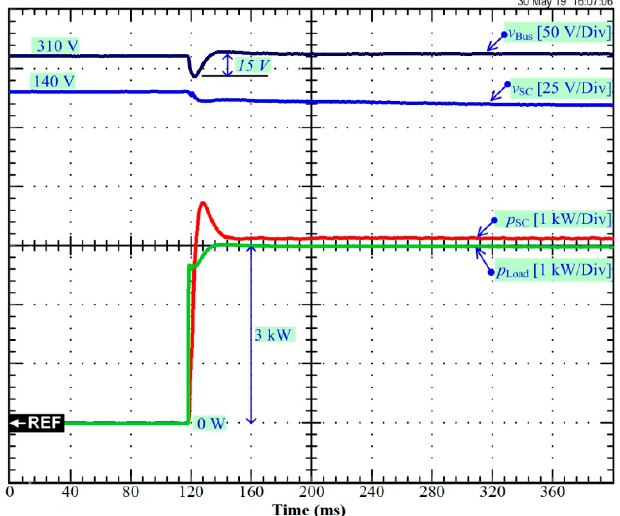
Figure 11. Experimental results: DC bus voltage stabilization of the studied hybrid power plant during load step from 0 to 3 kW.